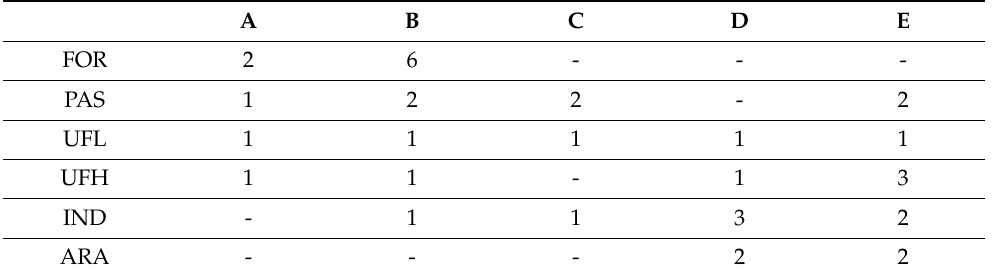
Table 3. Number of plots on each different land-use class (N), the median (Med.), minimum (Min.),